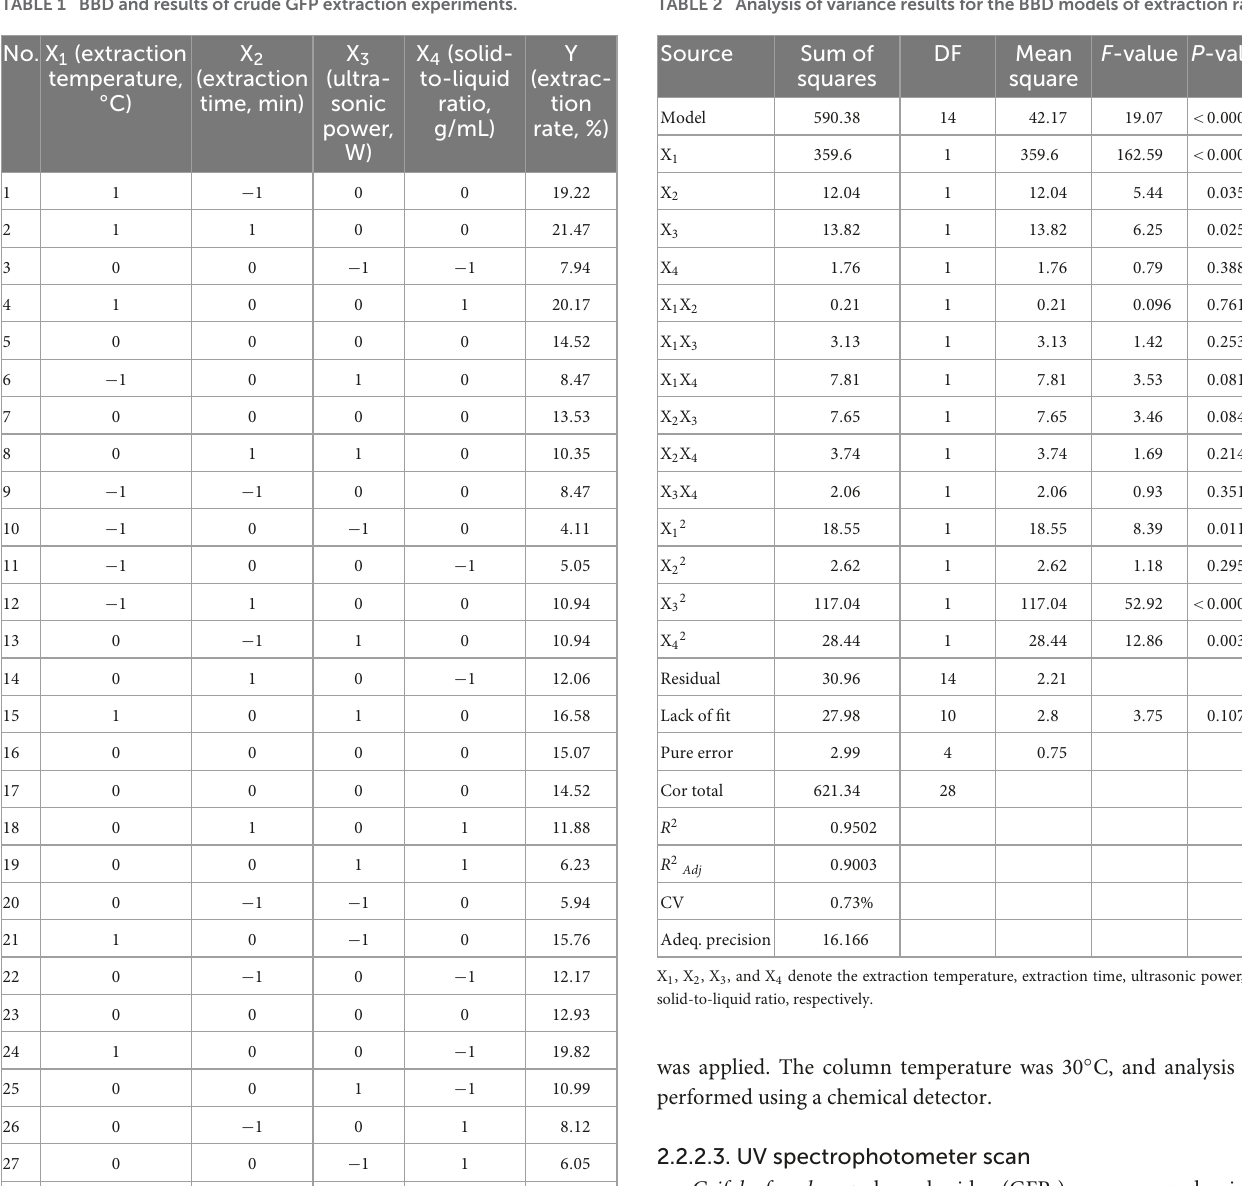
TABLE 1 BBD and results of crude GFP extraction experiments. TABLE 2 Analysis of variance results for the BBD models of extraction